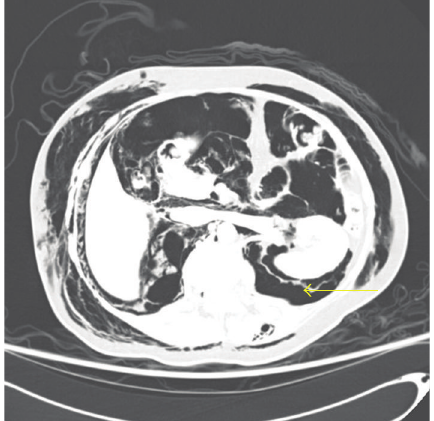
Figure 5: Transverse section of CT abdomen showing subcutaneous emphysema, pneumoperitoneum, and pneumoretroperitoneum (arrow).